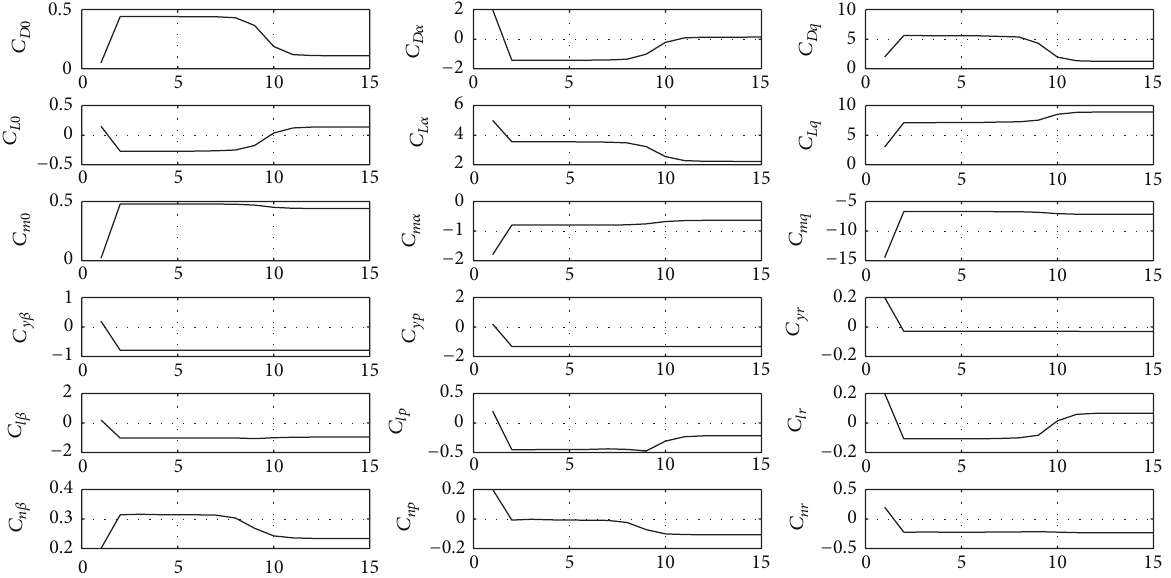
Figure 7: Convergence of maximum likelihood model parameter estimates.